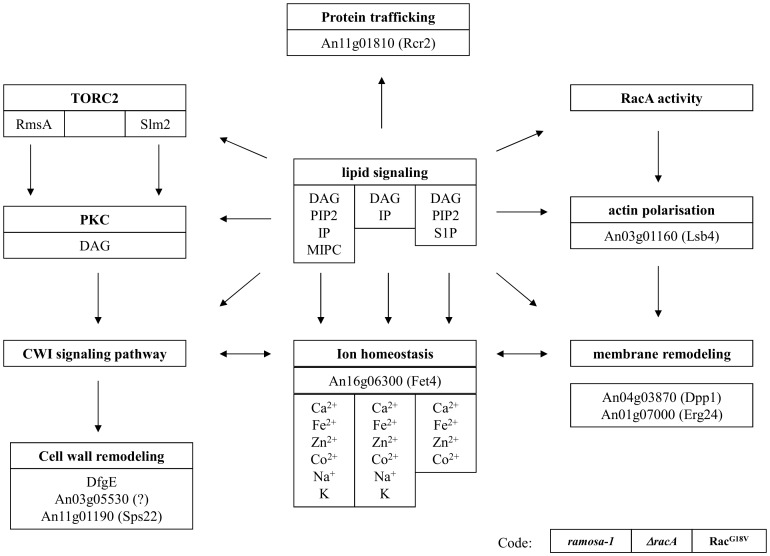
A reconstructed model for the morphogenetic network of A. niger based on the transcriptomic fingerprints determined for the apical branching mutant ramosa-1
[25], the apical branching mutant ΔracA (this work) and the apolar growing mutant PglaA-RacAG18V (this work).The model also rests on cell biological and phenotypic data obtained for all three strains (this work and [25]) as well as on literature data for conserved mechanisms from yeast to humans (see discussion for references). Indicated are signalling and metabolic processes, which showed transcriptional responses in all three strains, some deduced key players and the hypothetical connection of these processes.